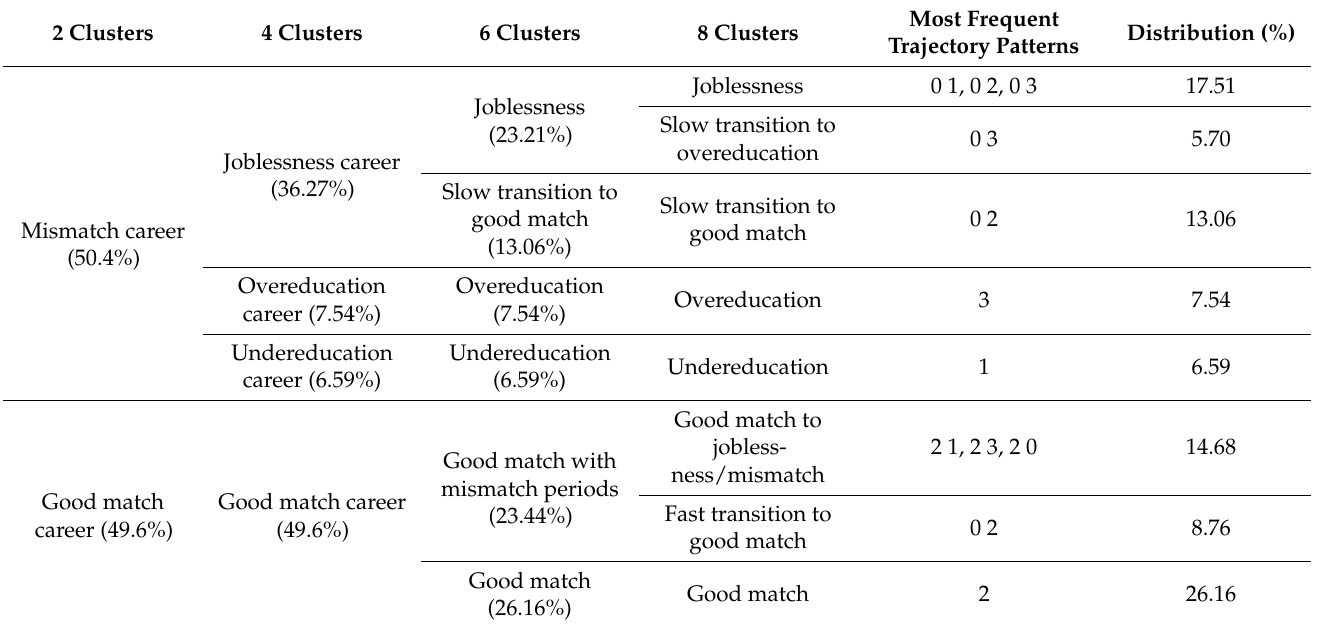
Table A2. Educational mismatch trajectory clusters. Optimal sequence matching solutions with 2, 4, 6, and 8 clusters. 2